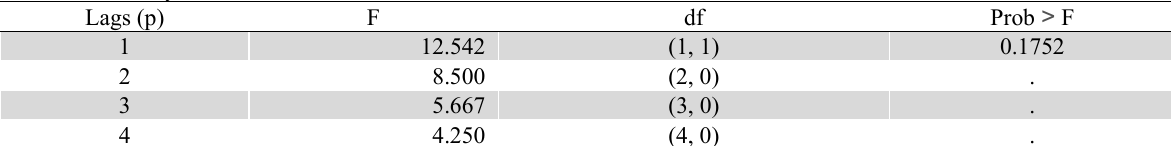
Table 5 Autocorrelation test to the ARDL model (1,2,4,4) Breusch-Godfrey LM test for